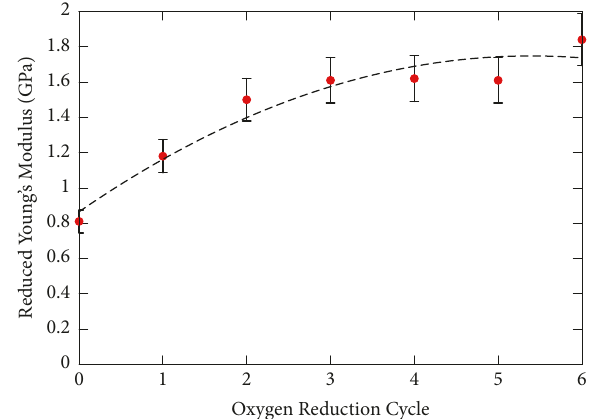
Figure 18: This plot compares the reduced Young’s modulus of the sample based on the number of LightScribe reduction cycles. The red points are the average values for the thirty data points taken after each cycle. In order to depict the changing nature of the elastic modulus, these points were fit using a polynomial function shown above. The reduced Young’s modulus increased for the first three reductioncyclesbeforelevelingoffduringthefourthandfifthcycles. The error bars depict the standard deviation of the reduced Young's modulus for the thirty data points taken after each reduction